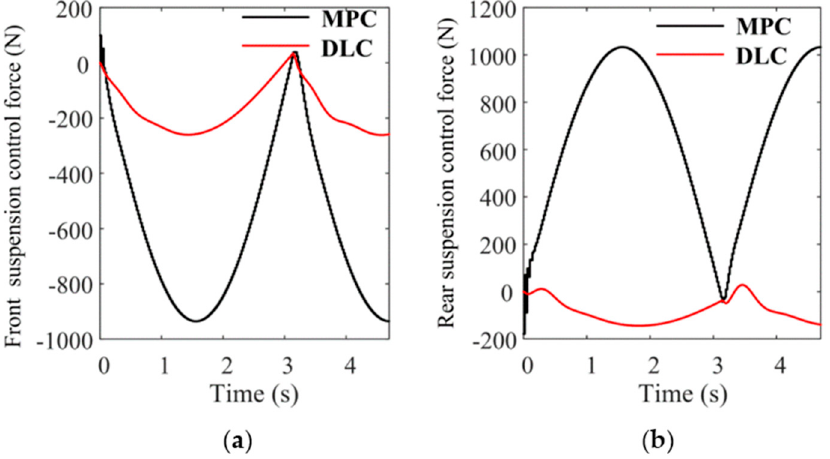
Figure 13. Front and rear suspension control forces. ( a ) Front suspension control force; ( b ) Rear suspension control force. suspension control force.